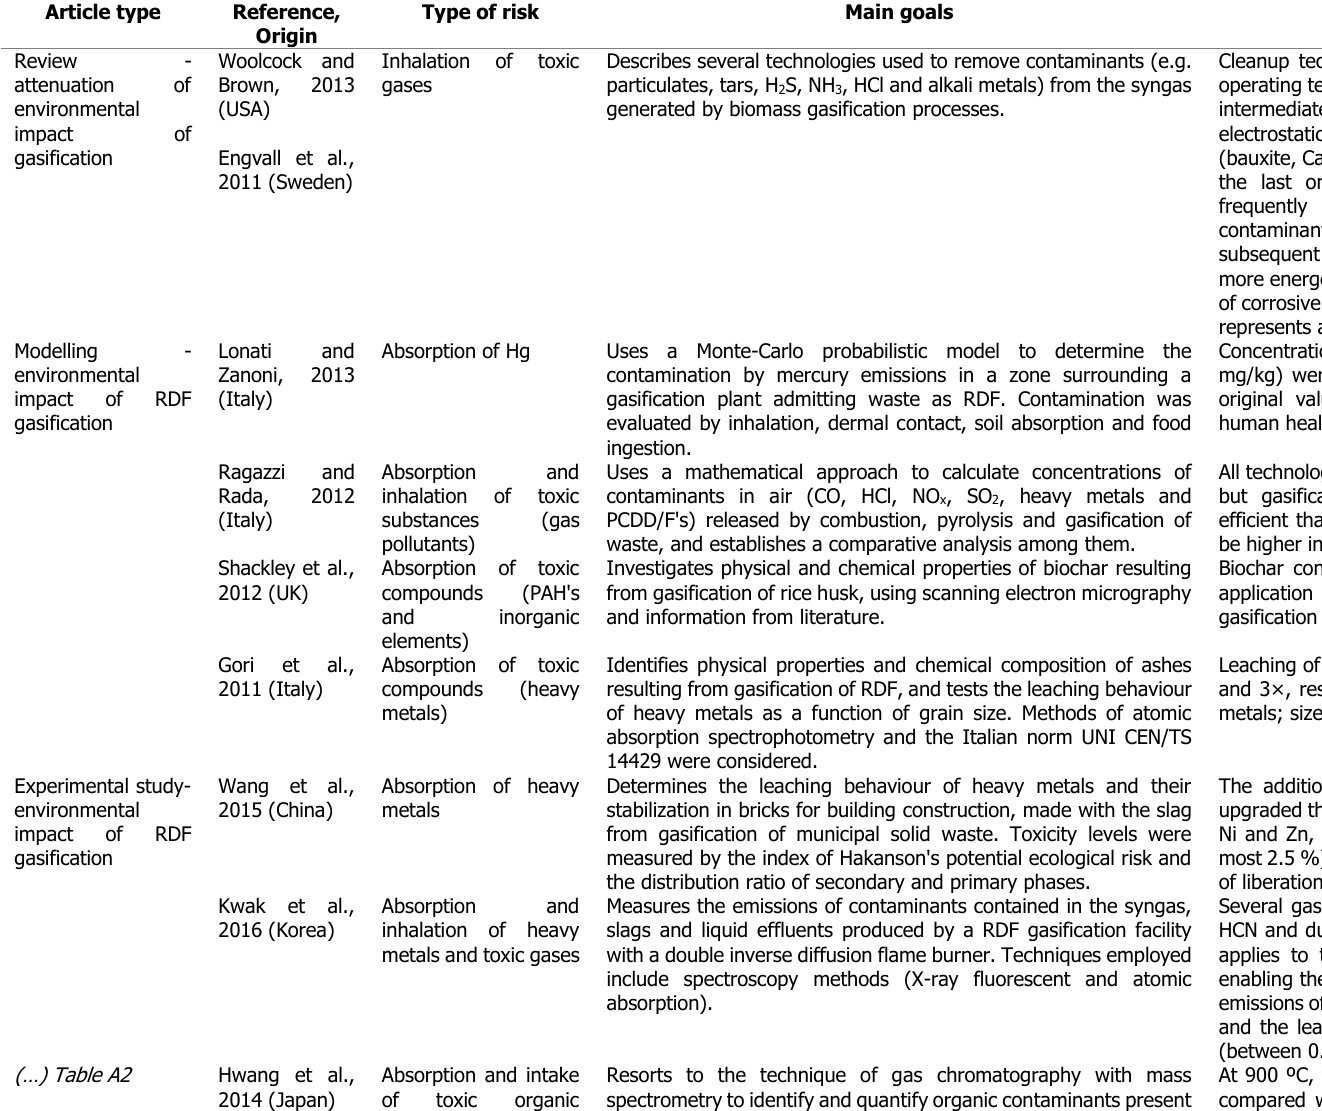
Table A2. Summary of published work on environmental impacts and losses caused by gasification plants (time span: